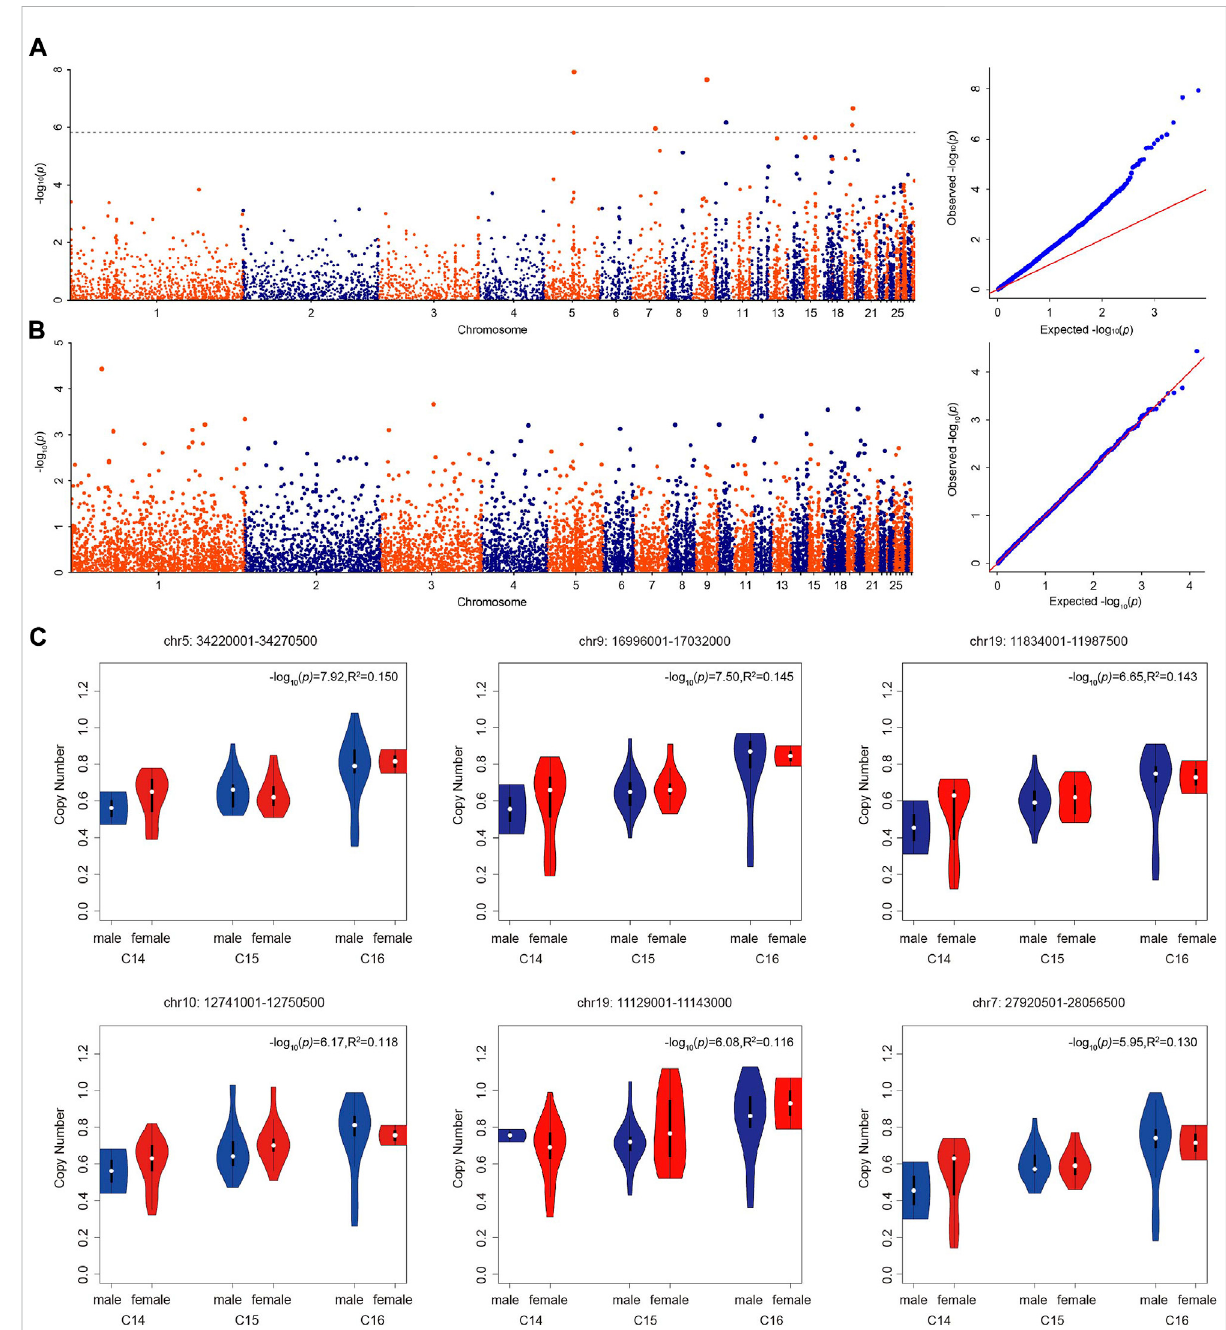
FIGURE 3 Genome-wide association analyses of the number of vertebrae. (A) Manhattan and QQ plots showing the signi fi cance of CNV effects on the number of cervical vertebrae. The black dashed line indicates the genome-wide signi fi cance of suggestive association ( − log 10 ( p ) = 5.84). (B) Manhattan and QQ plots showing the signi fi cance of CNV effects on the number of thoracic vertebrae. (C) The copy number of signi fi cant CNVRs (copy number variable regions) in male and female ducks with different numbers of cervical